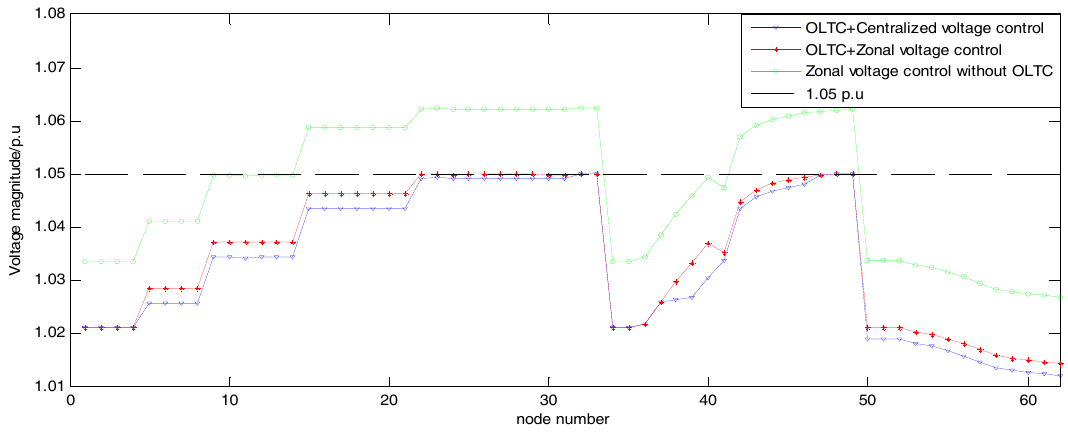
Figure 16. Voltage profiles under different cases.